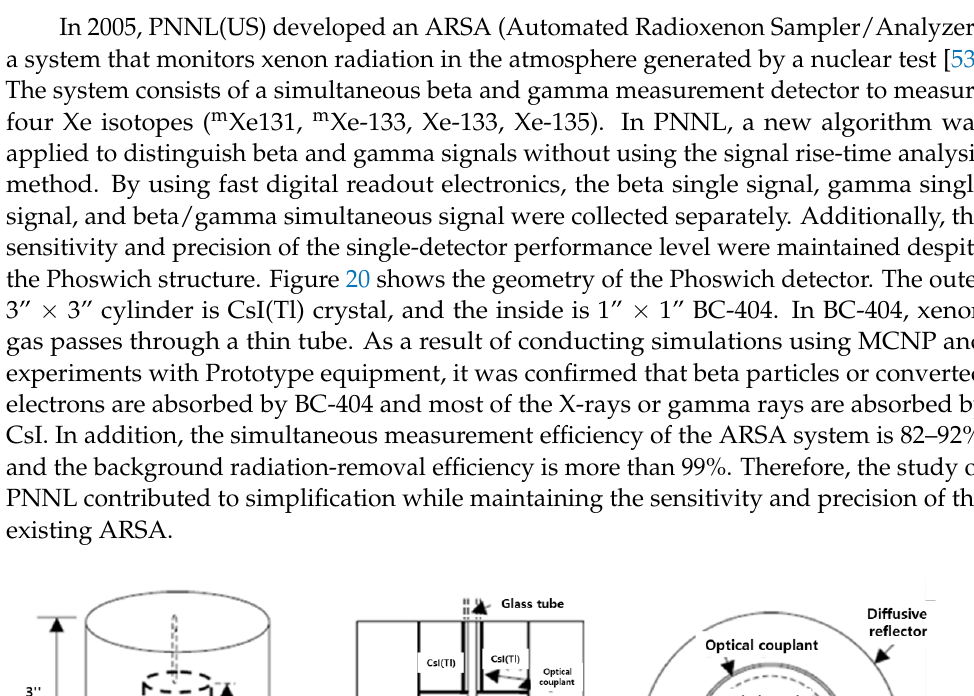
Figure 19. Phoswich detector fabricated by the University of Missouri-Columbia [52].